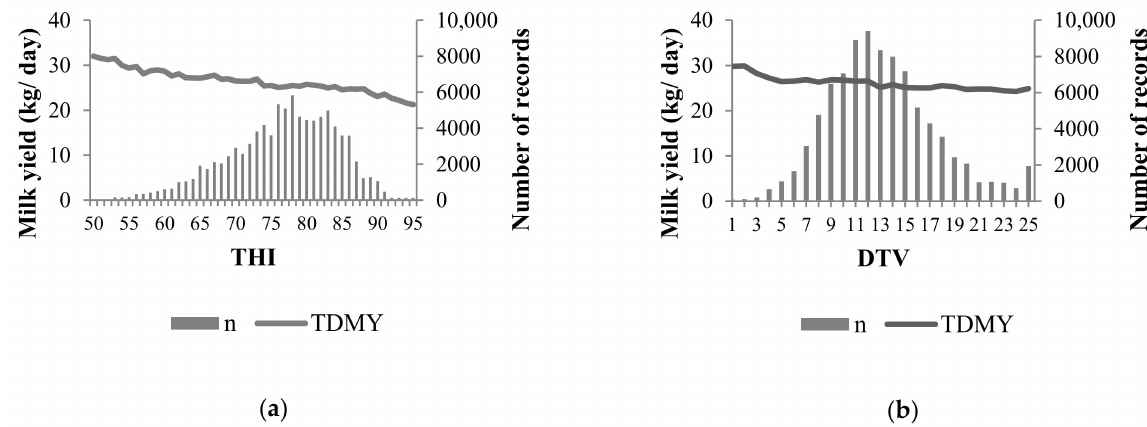
Figure 1. Number of records (n) and means of test-day milk yield (TDMY) per temperature–humidity index (THI) ( a ) and diurnal temperature variation (DTV) ( b ) in Brazilian Holstein cattle.